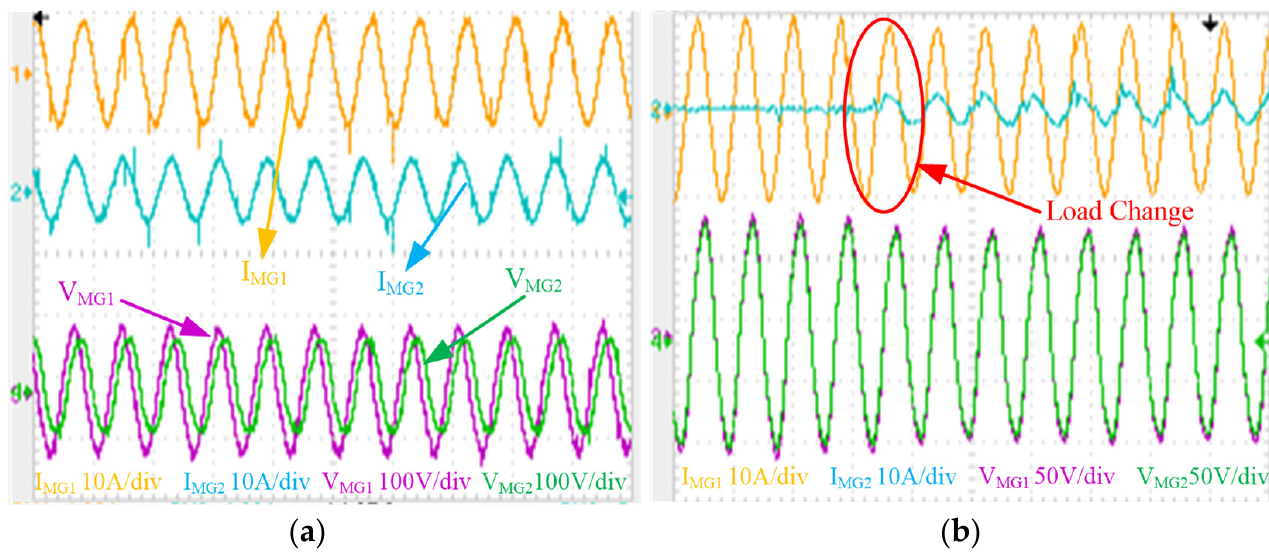
Figure 12. CMGs operating condition ( a ) in decoupled mode and ( b ) the effect of sudden load change.